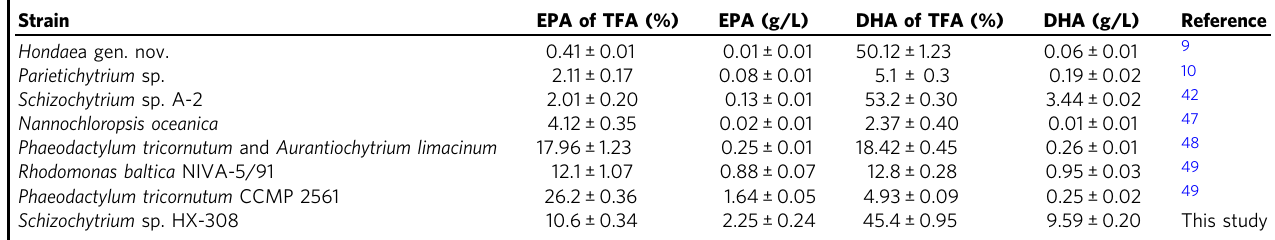
Table 1 The ability of microorganisms to co-produce EPA and